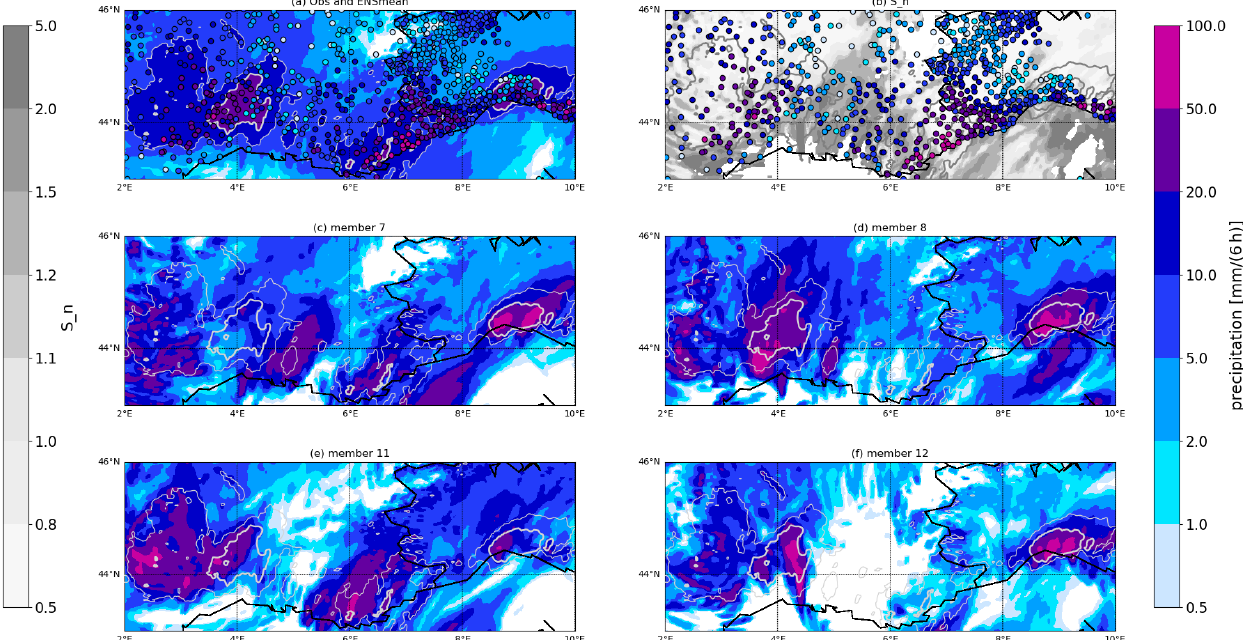
Figure 7. Illustration of 6-hourly precipitation for IOP16a valid 26 October 18:00UTC: (a) ensemble mean precipitation forecast (initialized 26 October 00:00UTC) and observations (filled circles); (b) normalized ensemble spread (grey) and rainfall observations (filled circles) for reference. Panels (c, d, e, f) show 6-hourly precipitation of selected individual ensemble members, all overlaid with 10 (thin) and 20mm (thick line) ensemble mean precipitation